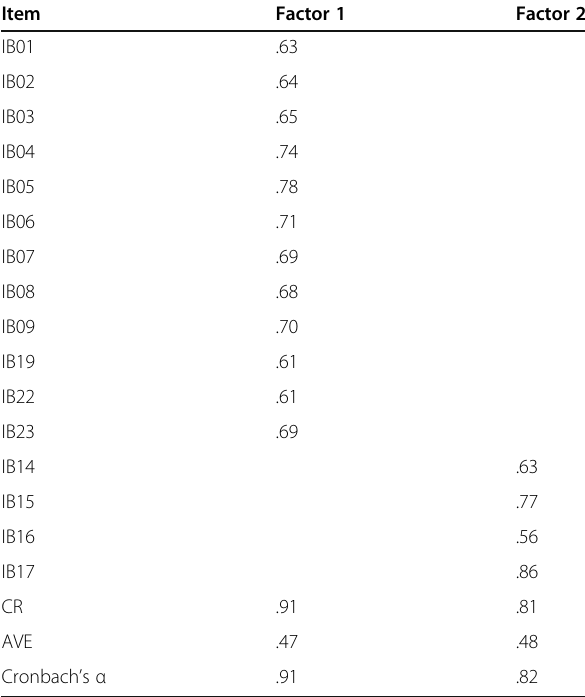
Table 5 Modified two-factor model of standardized factor loadings and